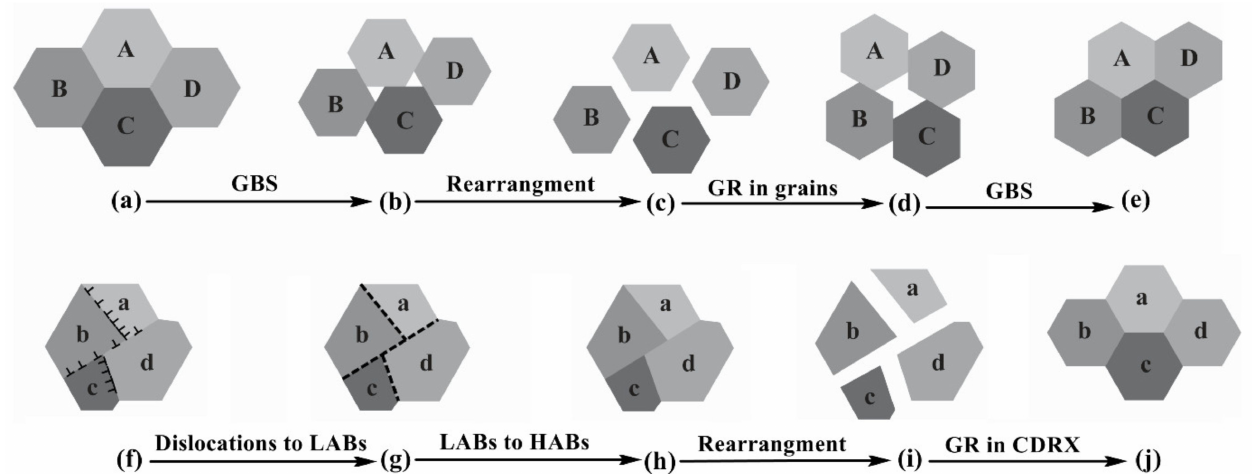
Figure 9. Schematic diagram of GR accommodated the GBS